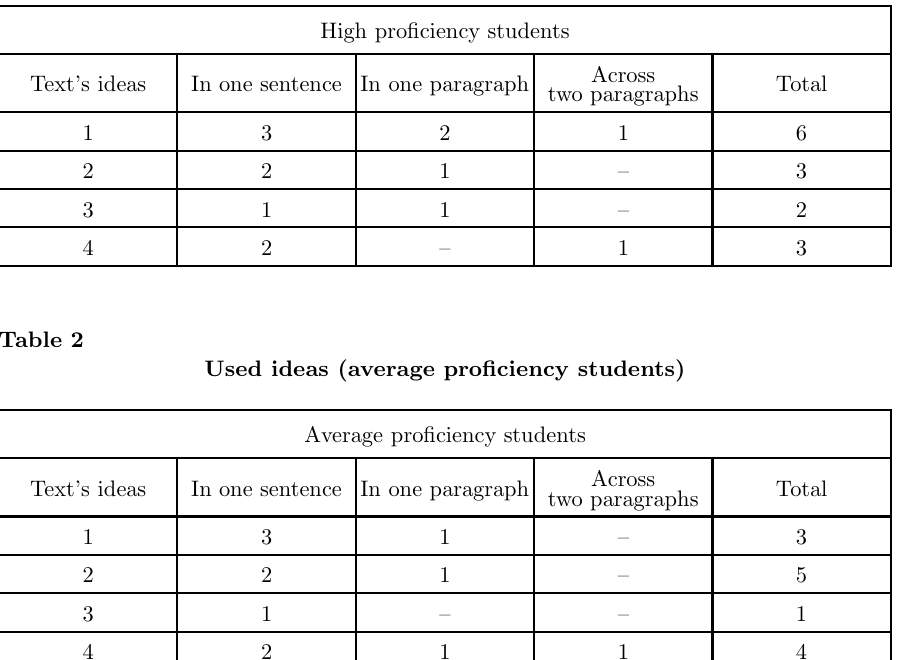
Used ideas (high proficiency students) High proficiency students Across Text’s ideas In one sentence In one paragraph Total two paragraphs